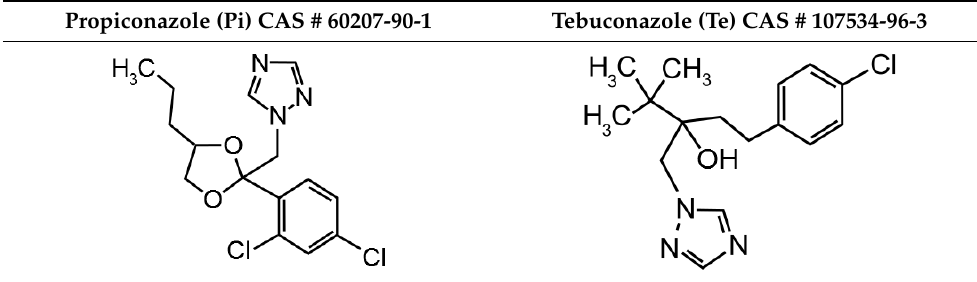
Table 1. Structural formulas of propiconazole (Pi) and tebuconazole (Te). Propiconazole (Pi) CAS # 60207-90-1